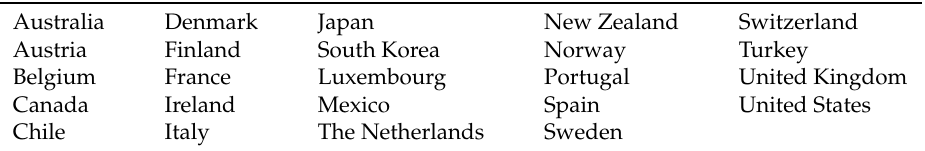
Table A1. List of OCDE countries.